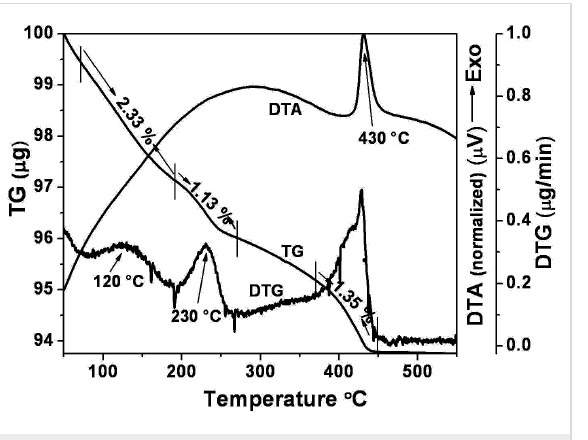
Figure 8: TG/DTG and DTA curve of h-MoO 3 .